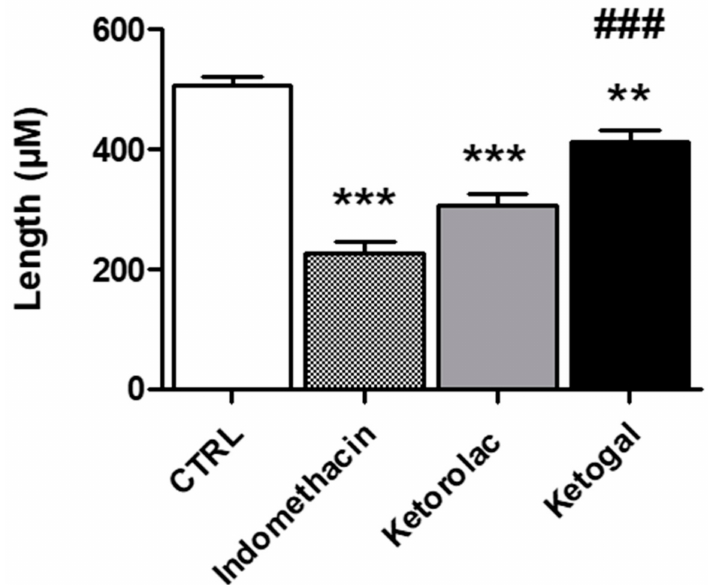
Figure 7. Effect of indomethacin, ketorolac, and ketogal on intestinal villi length ( µ m). Data are presented as means ± SEM ( n = 3). Significance of indomethacin, ketorolac, or ketogal versus untreated: ** p < 0.01; *** p < 0.001. Significance of ketogal vs. ketorolac: ### p <